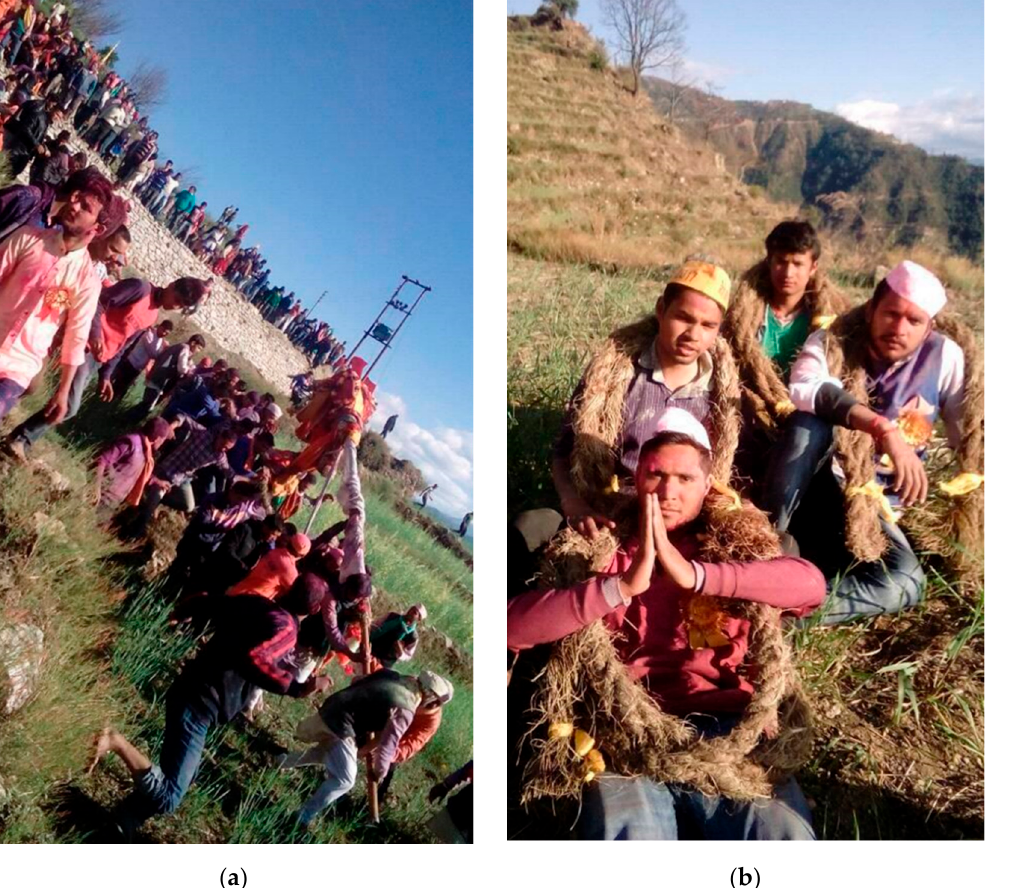
Figure 2. The Nai ṇ ī goddess of the village Rains runs downhill in the twofold-body of a bamboo pole and the rope made of babul ū grass ( a ). The rope body is then cut into pieces and taken home as pras ā d, the Goddess’s embodied blessing ( b ). I can use these images with the friendly permission of Kapil Negi, who took these images and shared them on Facebook under the title mata ka prsad Seera le jate Bhaktjan , “the devotees take the rope as Mother’s pras ā d ”.